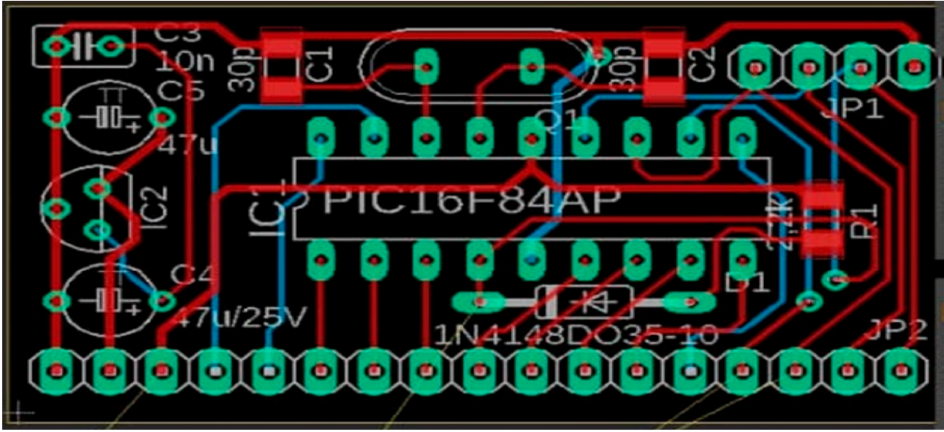
Figure 23. Design of the printed circuit board of the smart beehive mobile application